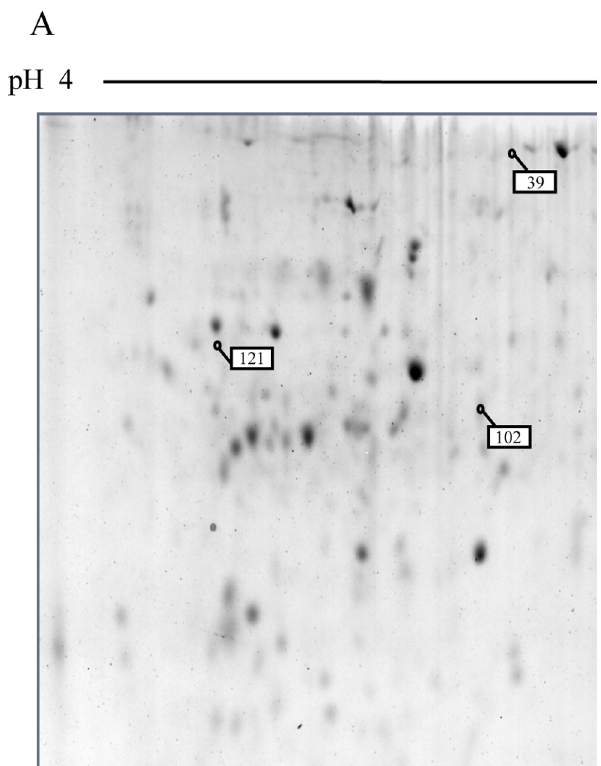
Figure 3. 2D electrophoretic profiling of Suberitesdomuncula primmorph extracts in response to 10 2 6 M of N -3-oxododeca- noyl- L -homoserine lactone (3-oxo-C 12 -HSL). Images correspond to representative gels of a total 3-oxo-C 12 -HSL-stimulated